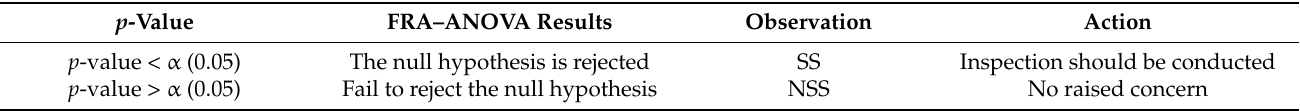
Table 2. Proposed ANOVA for interpretation of FRA